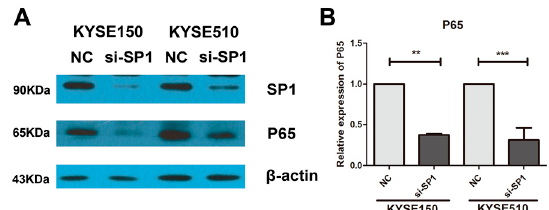
Figure 5. Knockdown of Sp1 inhibited the transcription of NF- κ B ( p65 ). ( A ) The protein levels of Sp1 and NF- κ B ( p65 ) were measured by Western blotting assay ( n = 3); ( B ) The mRNA level of NF- κ B ( p65 ) was determined by real-time PCR assay ( n = 3). NC: non-specific negative control. Three independent experiments were performed. ** p < 0.01; *** p < 0.001.